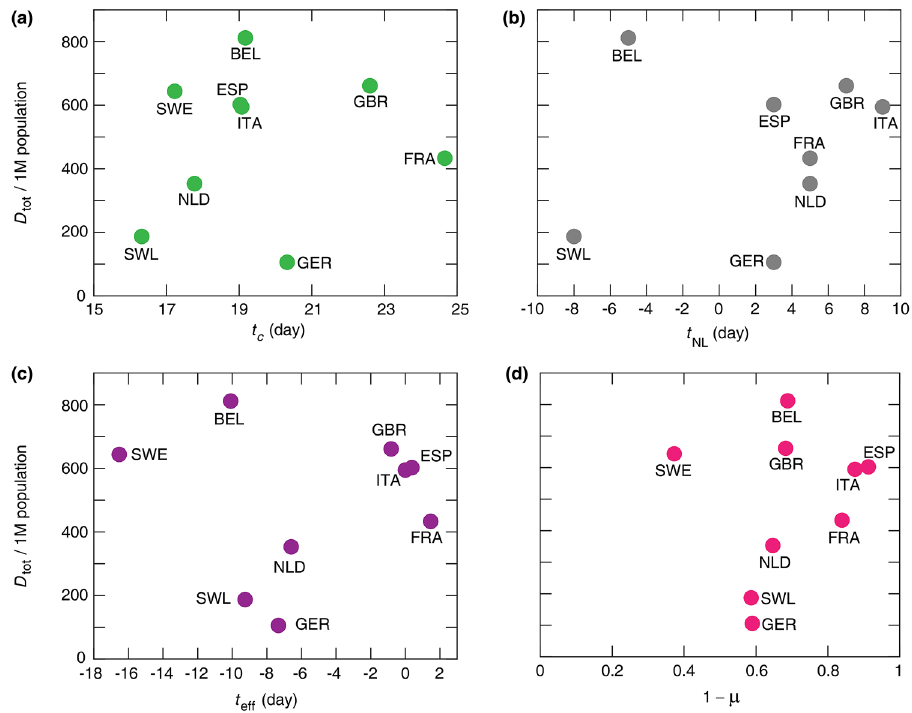
Figure 4. Actual total number of deaths per million (1M) population versus mean t c , the peak time of daily deaths ( a ), t NL national lock-down date ( b ), t eff effective lock-down date ( c ), and 1 − µ , the relative mobility drop ( d ). Pearson correlation coefficients are ( a ) r 2 = 0.01 ( p = 0.77 ), ( b ) r 2 = 0.06 ( p = 0.52 ), ( c ) r 2 = 0.002 ( p = 0.92 ), and ( d ) r 2 = 0.04 ( p = 0.62 ) indicating that there is no statistically significant correlation among these epidemic